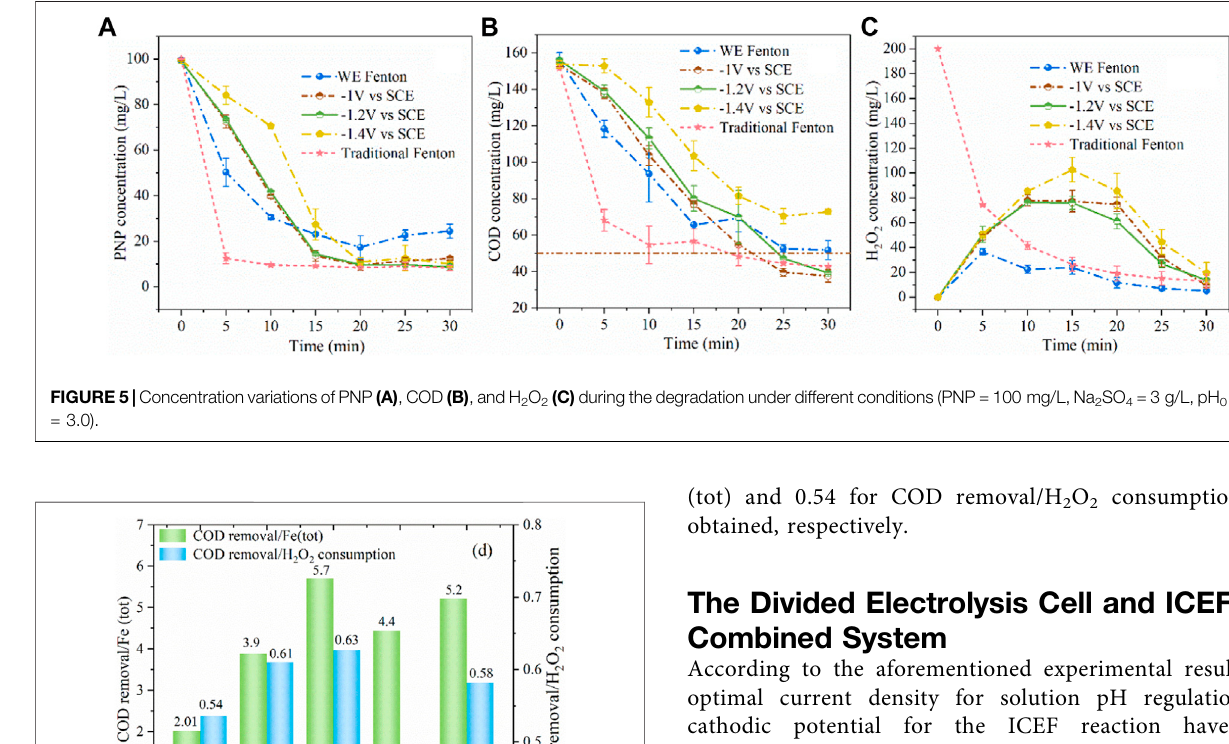
Frontiers in Chemistry |